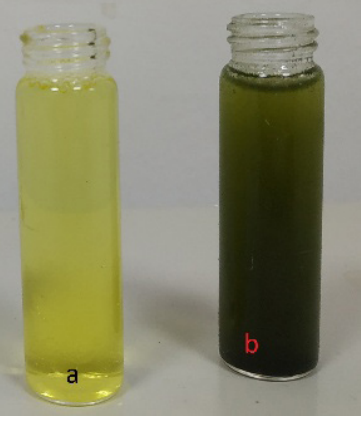
Figure 5: Colour of the lipids (a) after (b) before bleaching procedure